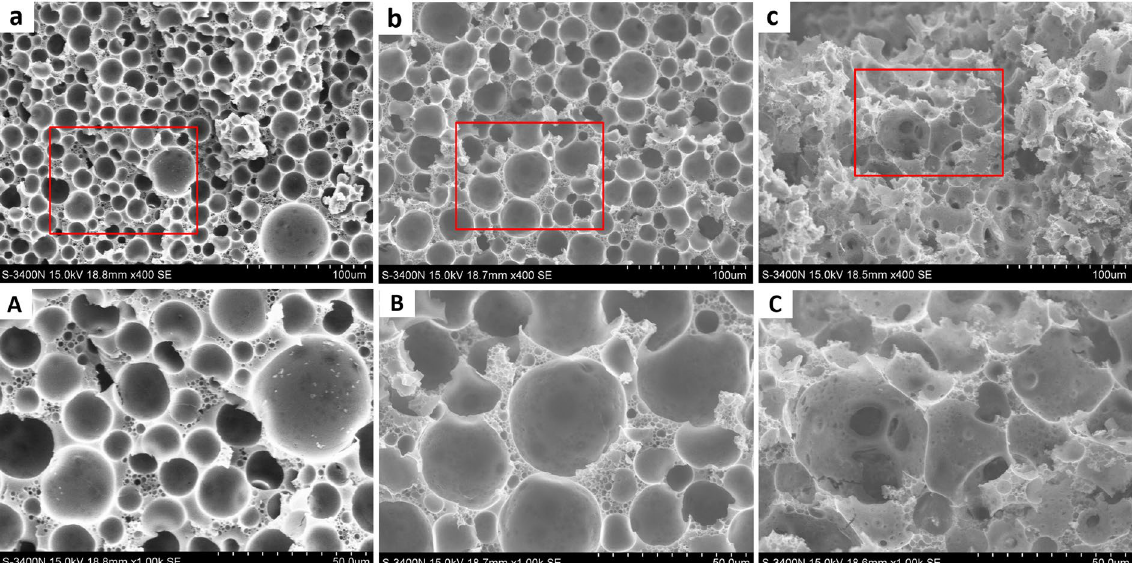
Figure 4. SEM photos of polystyrene monoliths prepared from emulsions stabilized by 5 wt% S-PBzMA polymer with ( a ) V w = 50%, ( b ) V w = 70% and ( c ) V w = 80%, respectively. The A, B and C are the enlarged images of red boxes in ( a , b and c ) respectively.